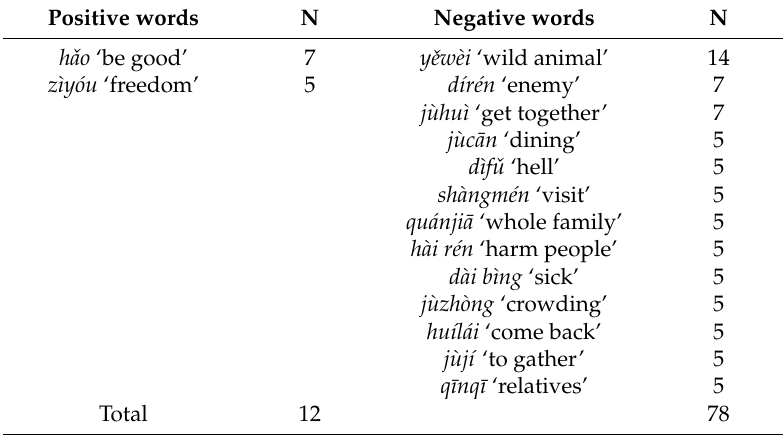
Table 7. Words with frequencies of 5 and over that appeared in ‘Confrontational banners; N =